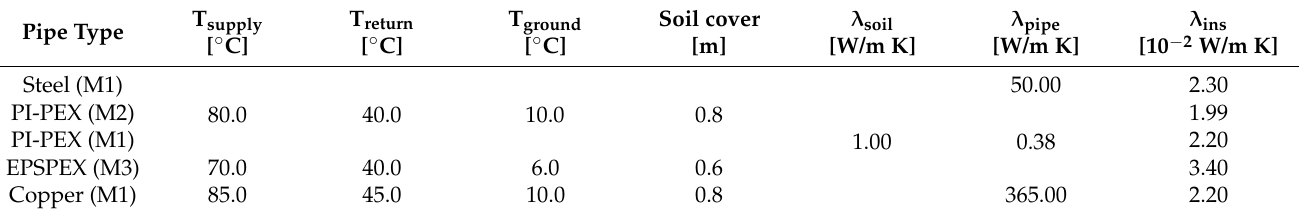
Table 5. Boundary conditions—Input values used for calibration of pipe heat losses in TRNSYS; catalogue heat transfer coefficients λ for pipe, soil insulation, and ground, as well as supply/return temperatures and soil